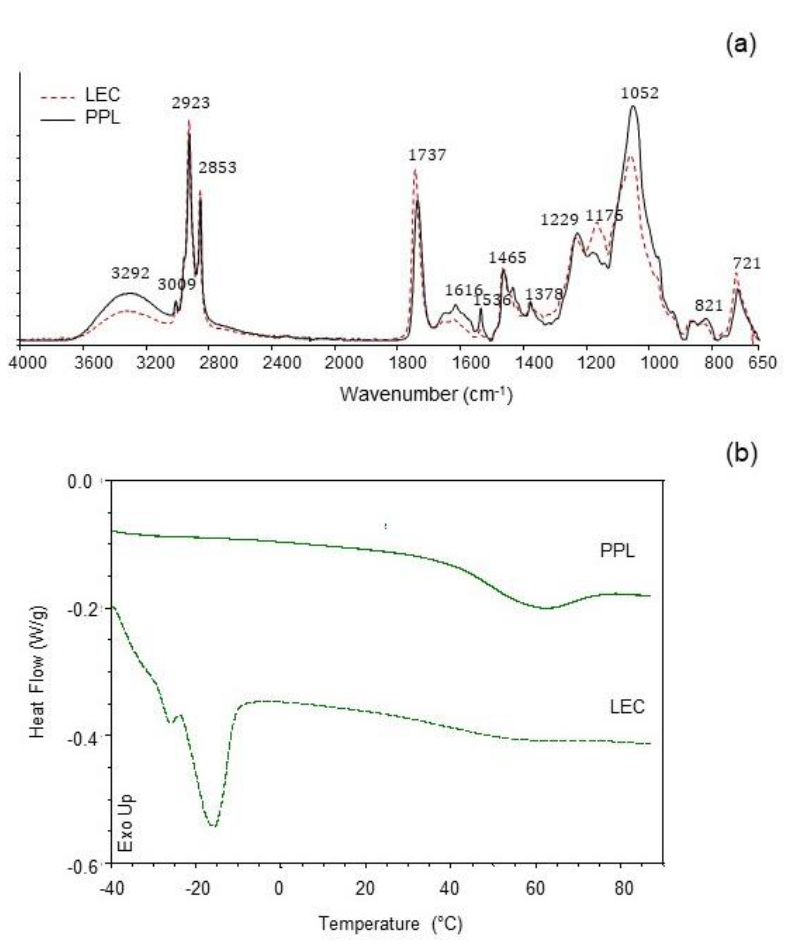
Figure 2. ( a ) Infrared spectra (ATR-FTIR) and ( b ) differential scanning calorimetry (DSC) traces of commercial rapeseed lecithin (LEC) and partially purified phospholipid fraction (PPL).